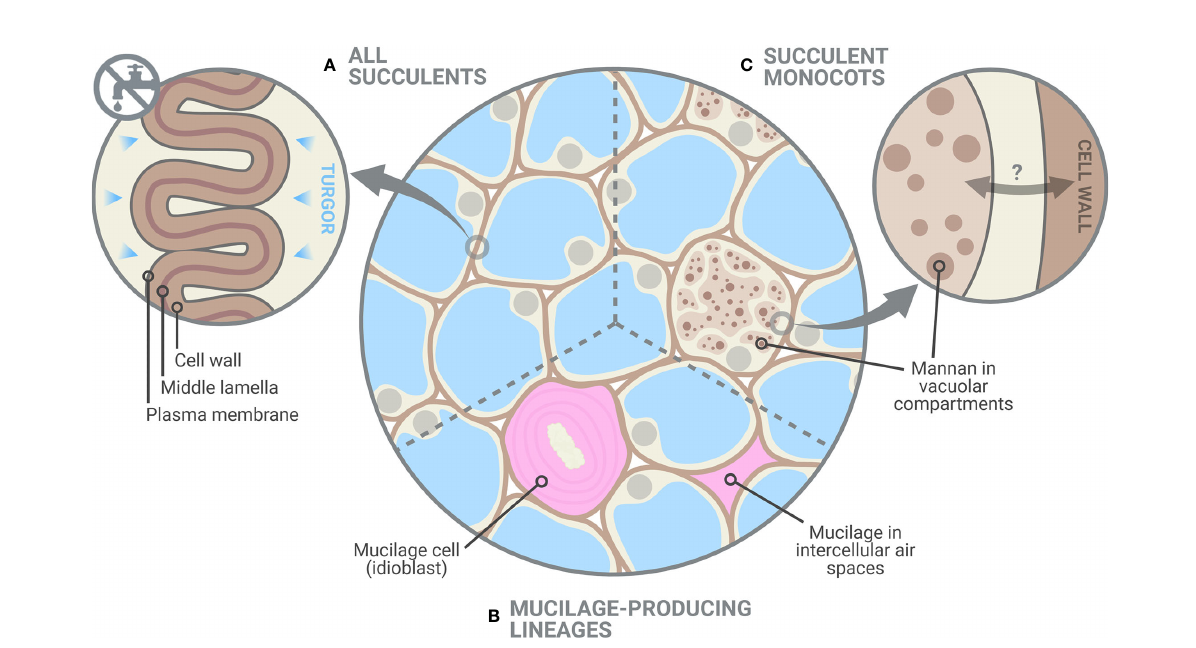
FIGURE 4 Glycomic diversity among succulent plants. (A) Succulent tissues have thin and highly elastic cell walls and, as shown in this study, elastic adjustment through cell wall remodelling likely plays a crucial role in preventing turgor loss during dehydration. Despite the clear differences between succulents and non-succulents, we also noted considerable glycomic diversity among succulents. (B) Mucilage-producing succulent lineages, mostly those in the Caryophyllales and particularly in the Portulacineae, accumulate pectin-rich mucilage in the periplasmic space of mucilage cells and/or in intercellular spaces, which boosts their water-storage capacity (Mauseth, 2005; Ogburn and Edwards, 2009). (C) Storage mannans can be found in vegetative tissues of many monocot lineages, often stored within vacuolar compartments. In succulent monocots, mobilization of these mannans may be part of the drought response, as seen in Aloe (Ahl et al., 2019), in which cell wall-associated mannan is remobilized into the protoplasm. However, the dynamics between cell-wall associated and vacuolar mannans in monocots remain largely unexplored. Created with